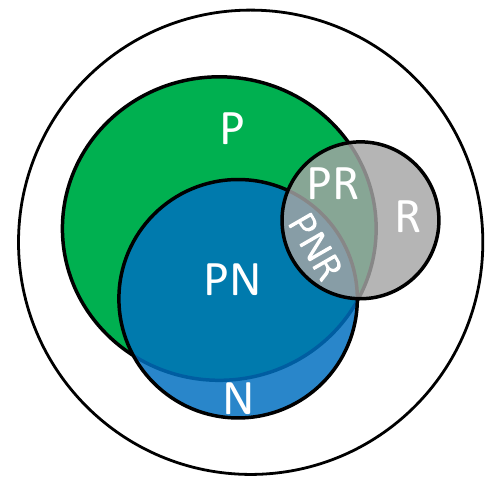
Figure 3. Permissions grouped by access: P , N , and R are groups of permissions assigned to P hysician, N urse, and BTG R estricted,